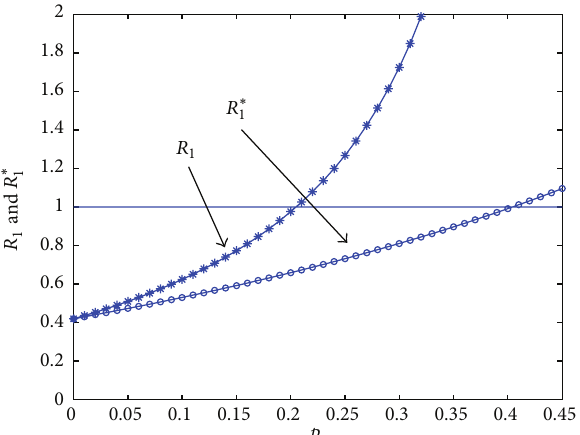
Figure 9: Comparing two kinds of control strategy; the parameter values are as follows: 𝑟 = 4.5, 𝜏 = 0.2, 𝜔 = 0.2, 𝛽 = 2, 𝑑 1 = 0.1, 𝑑 3 = 0.15, 𝑎 = 2, 𝑏 = 4 , and 𝑇 = 3 ; the killing rate 𝑝 varies from 0 to